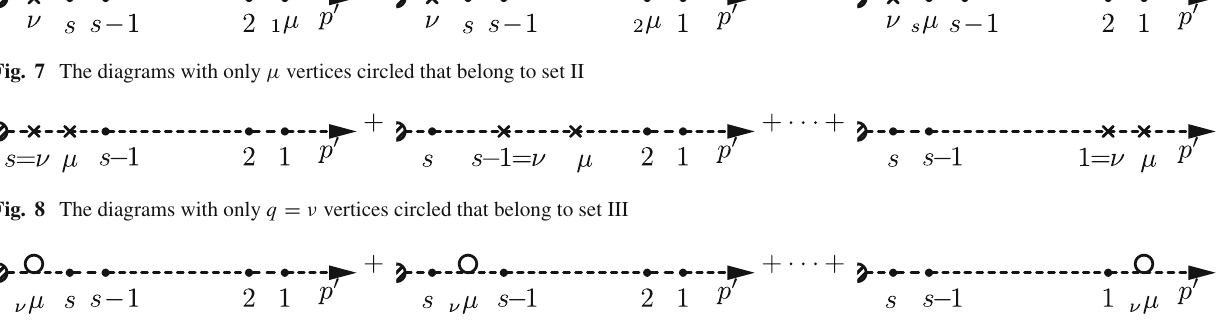
Fig. 9 The diagrams with ν μ circled vertices that belong to set IV. The last term corresponds to the self energy diagram and is to be omitted on the p leg to avoid double